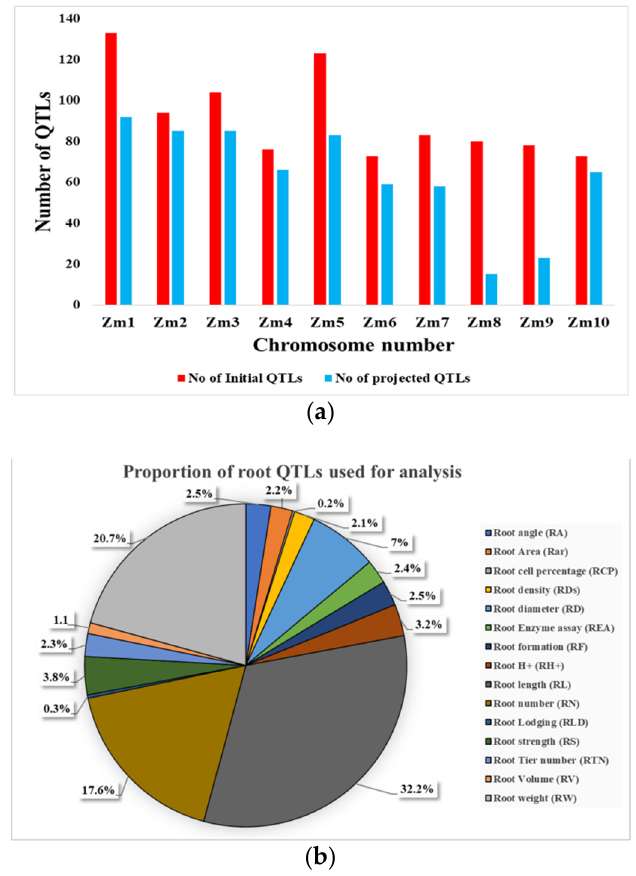
Figure 3 . ( a ) Bar graph representing the differences in number of QTLs before (red bar) and after projection (blue bar). ( b ) Pie chart representing proportion of root QTLs in different colours used for projection. The pie chart starts from root angle (RA; 2.5%) and ends with root weight (RW; 20.7%).